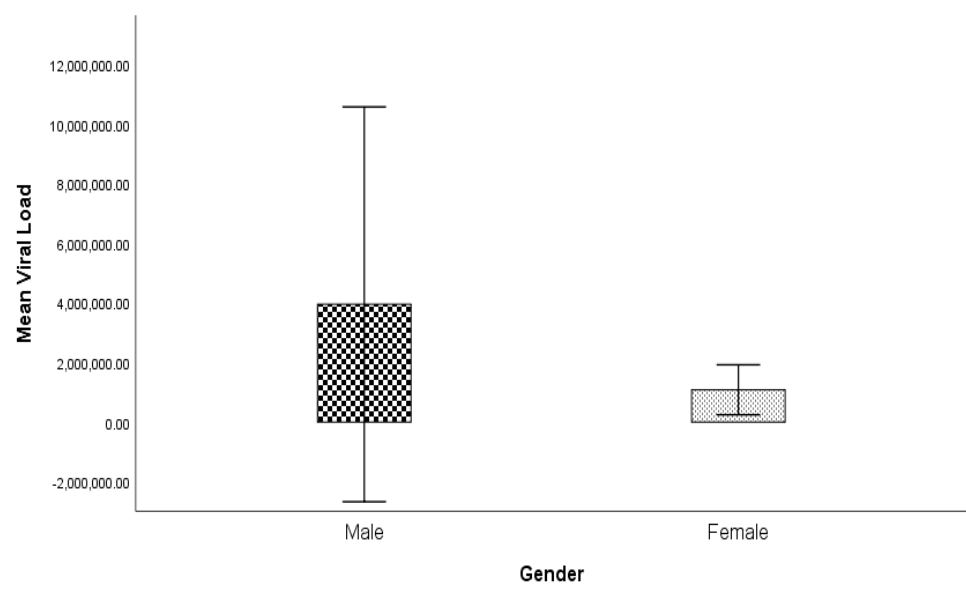
Figure 1. Graphical representation of comparison of viral load among males and females . Table 1. Primers of miRNAs (miRNA-182, miRNA-122, miRNA-21, miRNA-199, miRNA-150, and miRNA-222) .